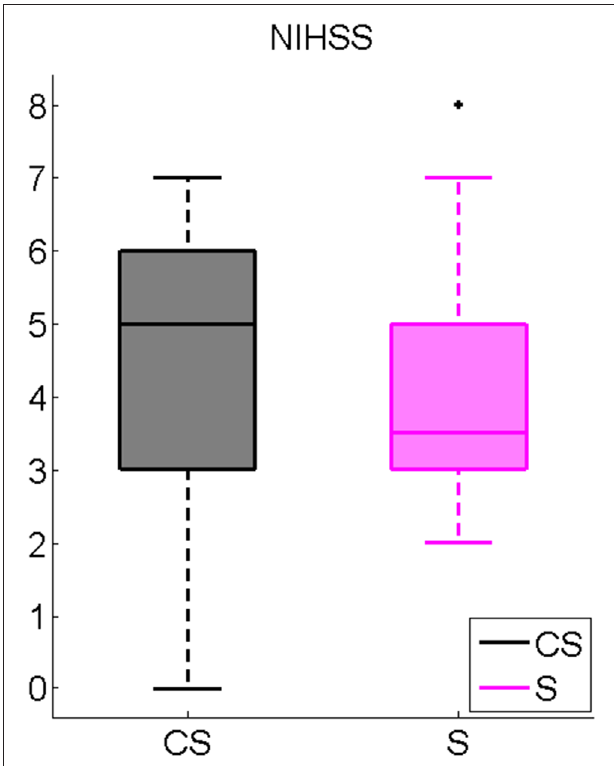
FIGURE 1 | National Institutes of Health Stroke Scale (NIHSS) inter-group comparison. Cortico-subcortical lesioned patients (CS), Subcortical lesioned patients (S).